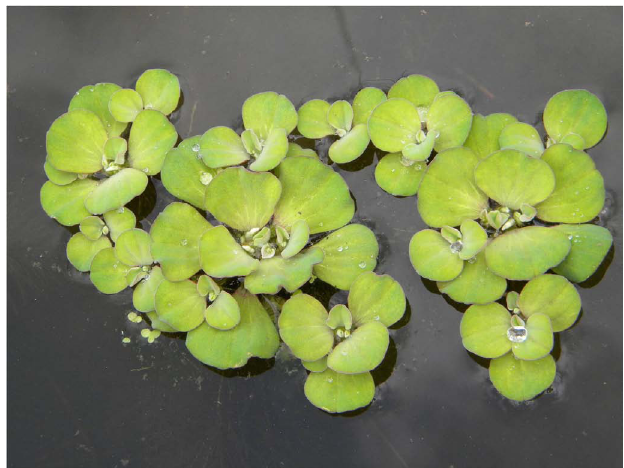
a sacred plant, yields edible nut-lets.